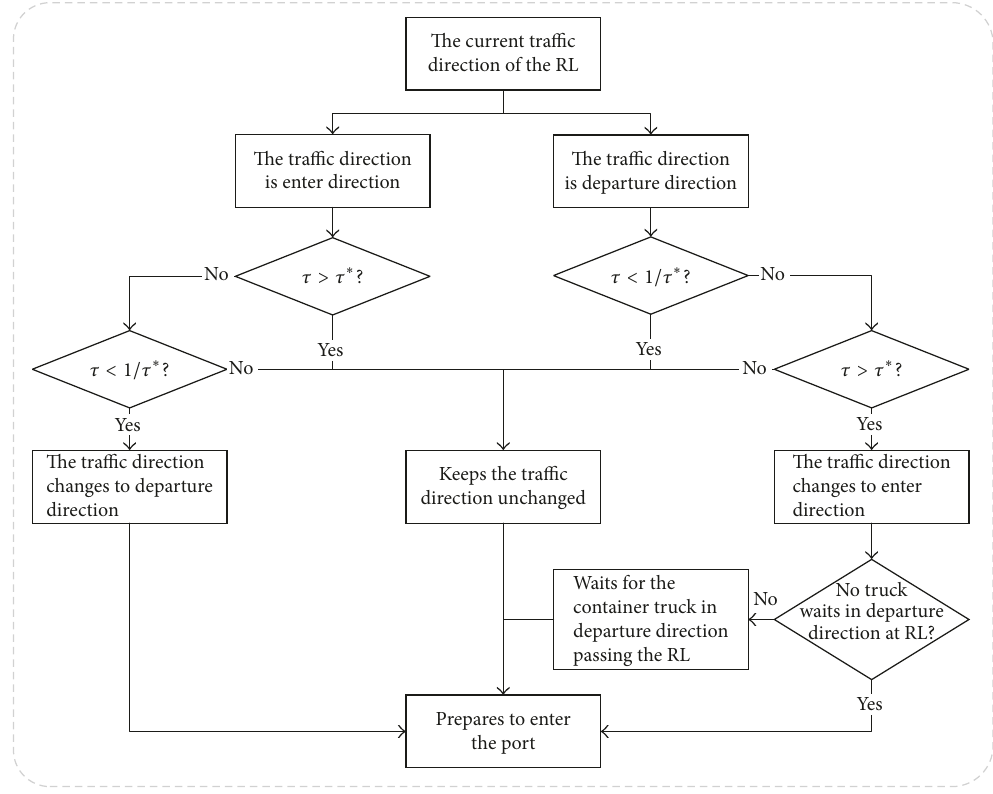
Figure 4: Logic of the changing traffic direction of RLs when container truck enters the